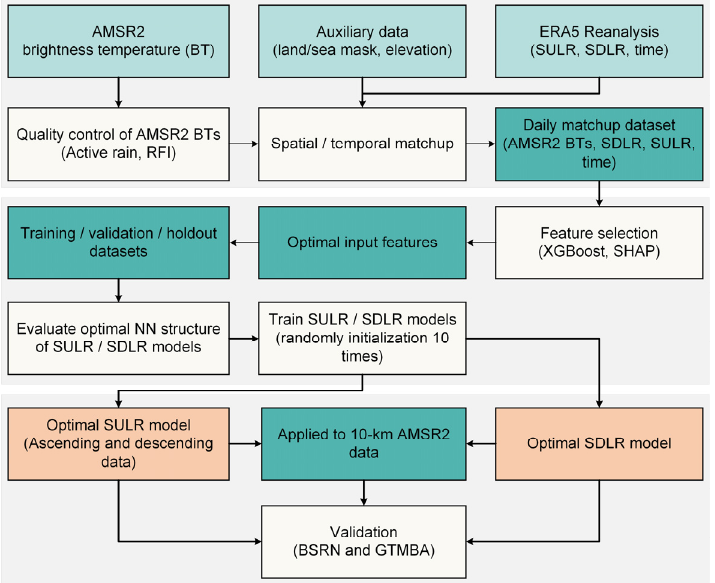
Figure 2. Workflow of constructing a retrieval model for all-weather surface longwave radiation from the Advanced Microwave Scanning Radiometer 2 (AMSR2) data. BSRN: baseline surface radiation network. ERA5: European centre for medium-range weather forecasts reanalysis v5. GTMBA: global tropical moored buoy array. NN: neural network. RFI: radio frequency interference. SDLR: surface downward longwave radiation. SHAP: Shapley additive explanation. SULR: surface upward longwave radiation.